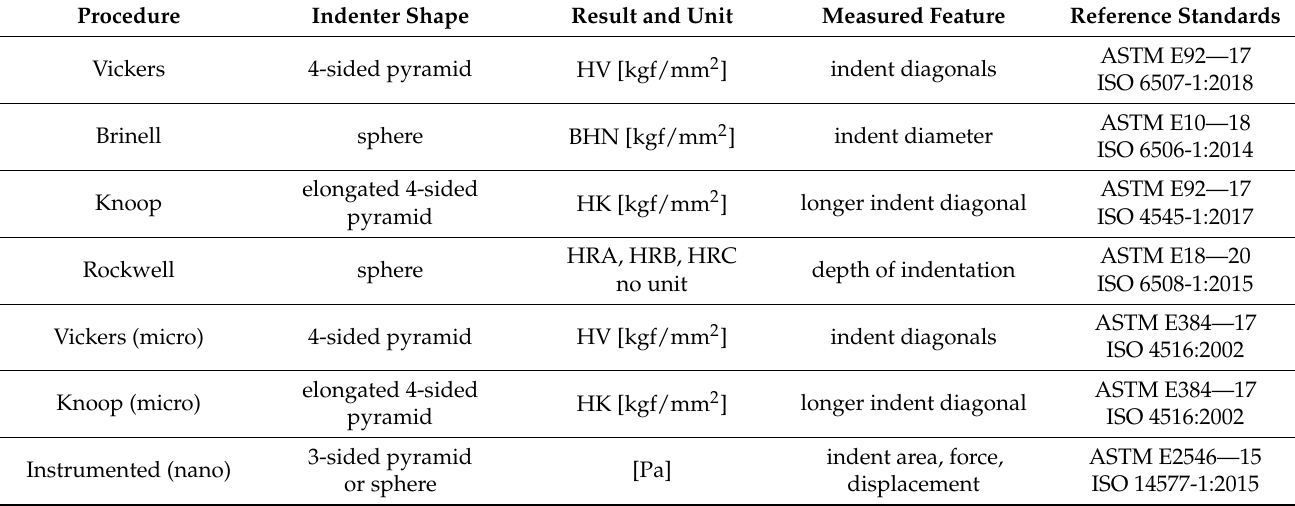
Table 1. Summary of indentation hardness